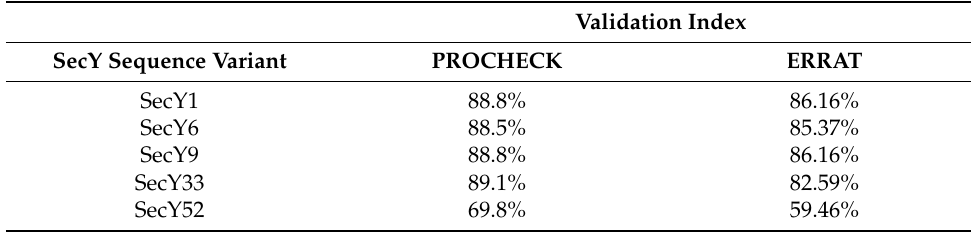
Table 2. Assessment of the predicted three-dimensional structures of SecY proteins by PROCHEK and ERRAT programs.